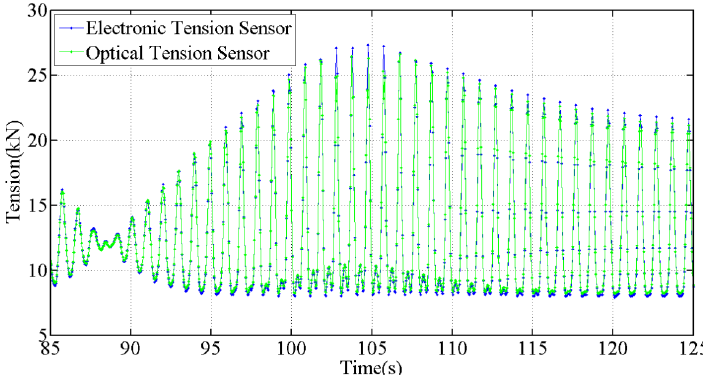
Figure 12. Tension measured by the optical sensor in the period of 85 s to 125 s, drive frequency is 1.02 Hz.